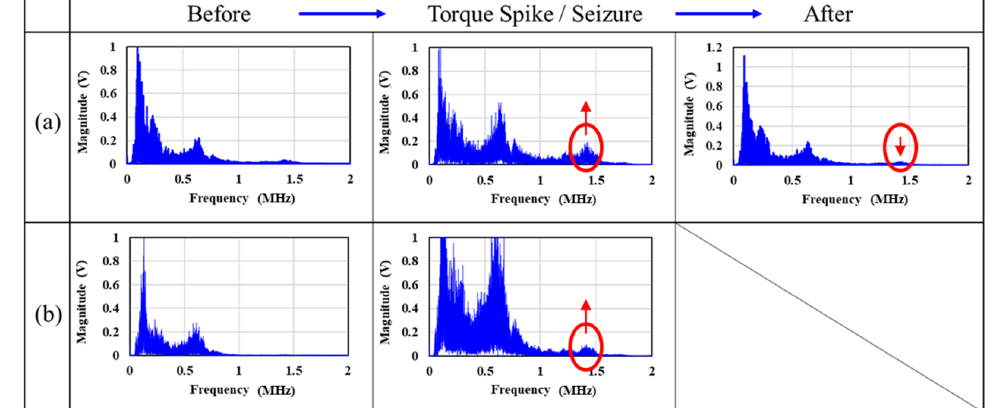
Figure 14. AE signal frequency characteristics for: ( a ) torque spikes and ( b ) until seizure occurred.